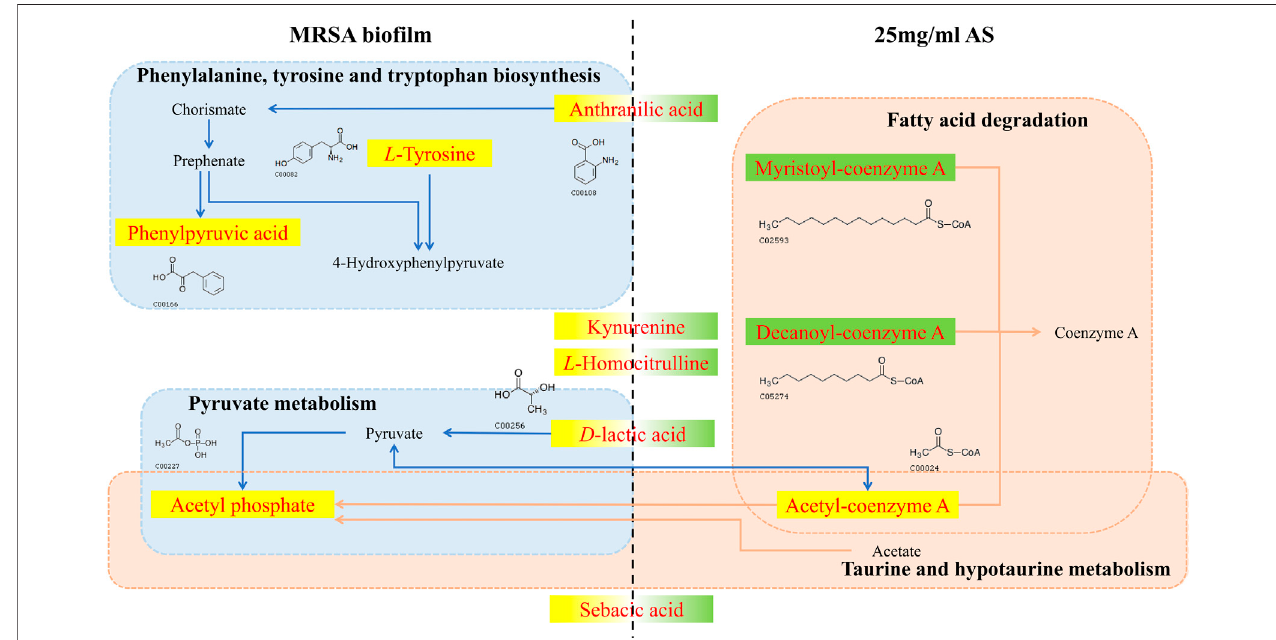
FIGURE 9 | Changes in different metabolites and their metabolic pathways in MRSA bio fi lms treated with or without AS. The red font indicates the differentially altered metabolite in the pathway. The yellow background indicates that the level of the metabolite increased, and the green background indicates a decrease. The blue dashed boxes indicate pathways in which metabolic biomarkers of the MRSA bio fi lm are involved in the absence of the intervention. Pink dashed boxes indicate pathways in which pharmacodynamic metabolic markers of AS are involved.